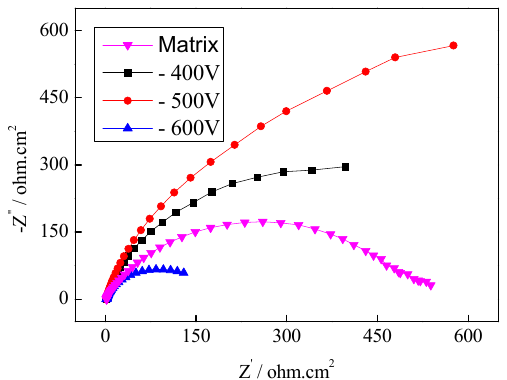
Figure 6. Electrochemical impedance spectroscopy (EIS) analysis of the plasma-nitrided coating under different bias voltages.